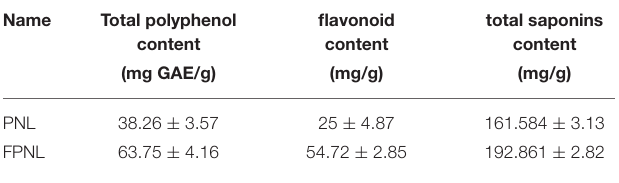
TABLE 1 | Contents of total polyphenols, flavonoids, and saponins in PNL and